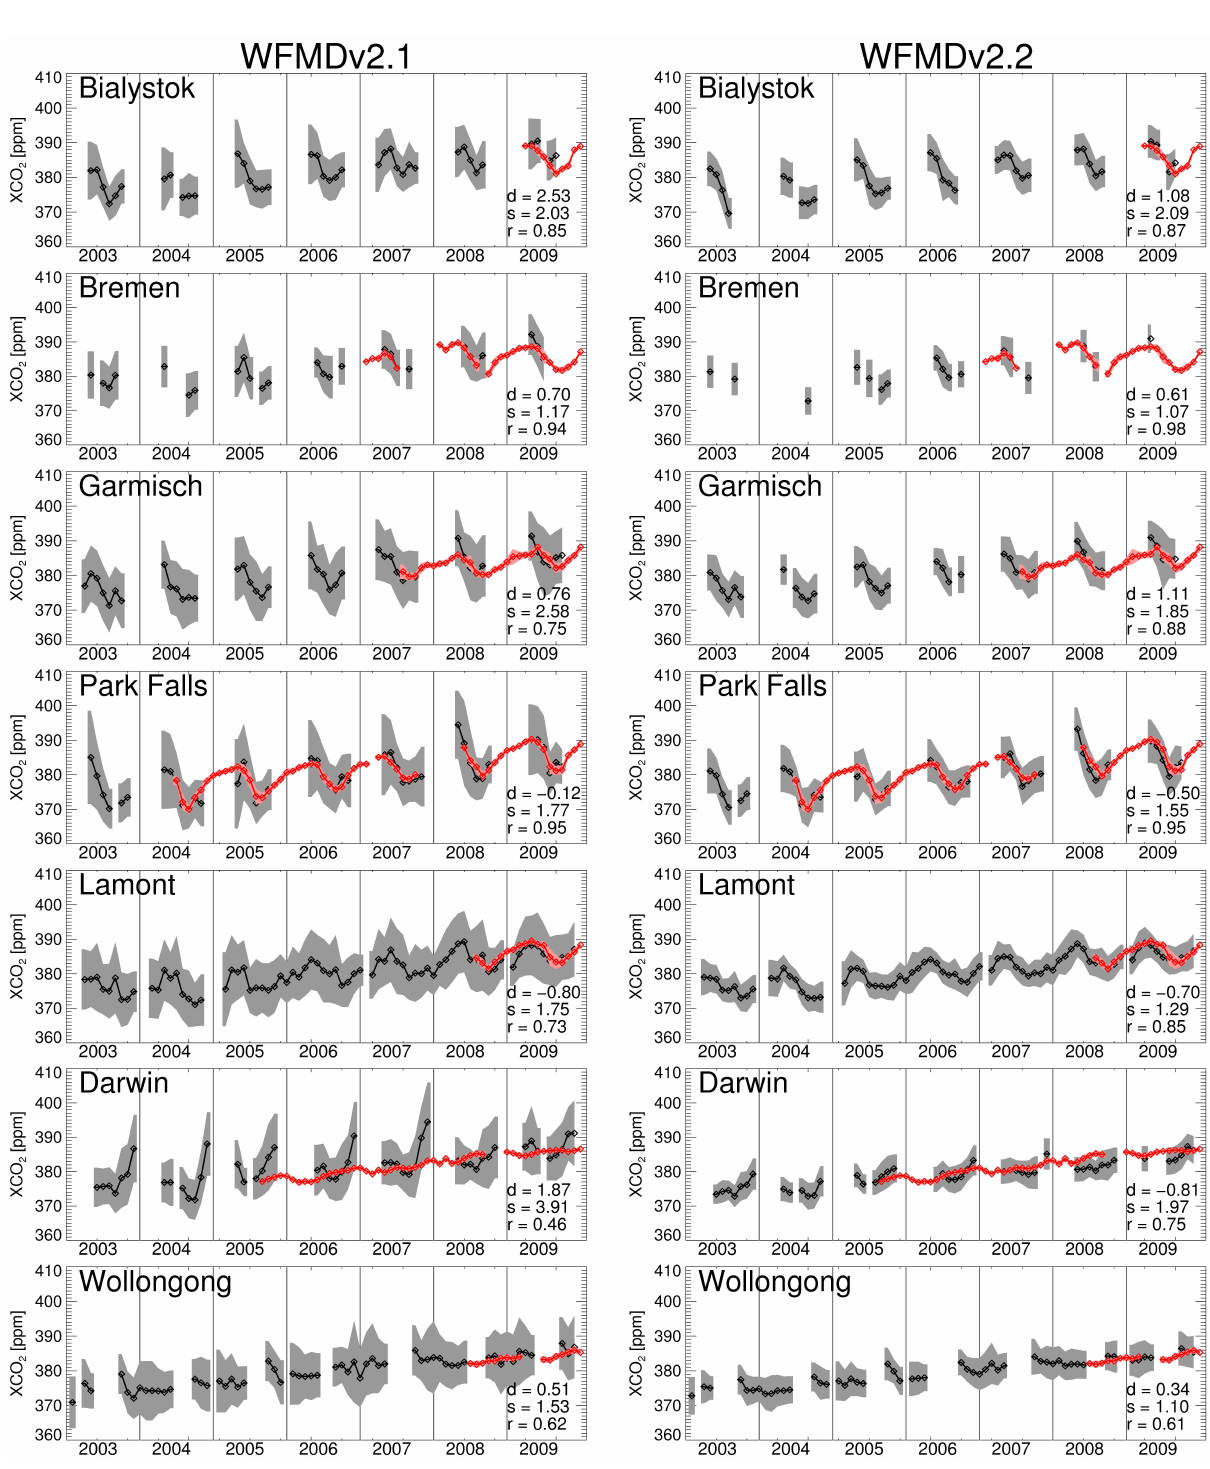
Fig. 7. Comparison of monthly averaged SCIAMACHY WFM-DOAS version 2.1 (left) and 2.2 (right) X CO 2 (black) with Fourier transform spectroscopy (FTS) measurements (red) at various TCCON sites for the years 2003–2009. The monthly standard deviations are represented by the shaded areas (grey: WFMD; light red: TCCON). In addition, the mean difference ( d [ppm]), the standard deviation of the difference ( s [ppm]) and the correlation ( r [-]) between the satellite and ground based data are shown (see also Table